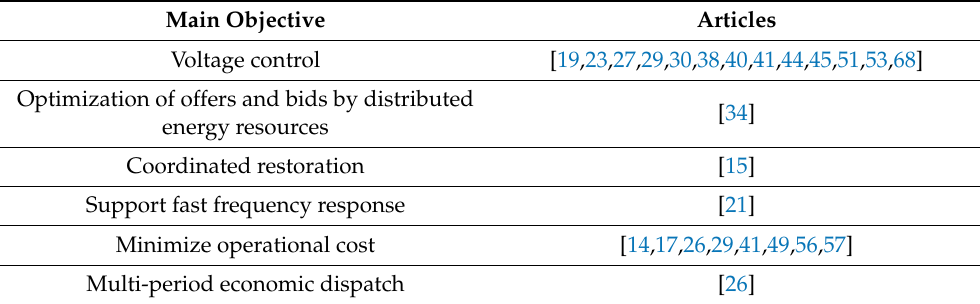
Table 7. Main objectives of the articles that develop and implement a TSO/DSO coordination